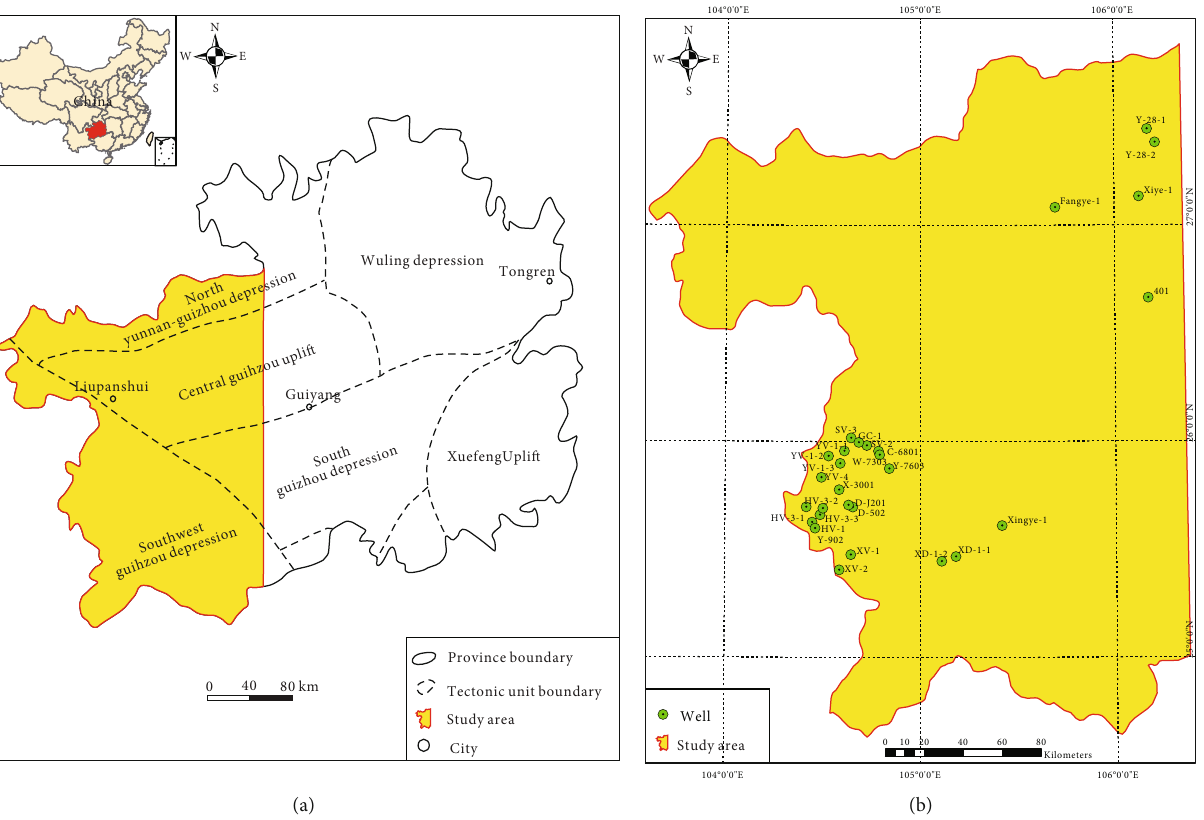
Figure 1: Regional sketch map showing (a) major tectonic units (modi fi ed from Luo et al. [29]) and our study area in the Guizhou Province and (b) well (green- fi lled circle) locations in the study